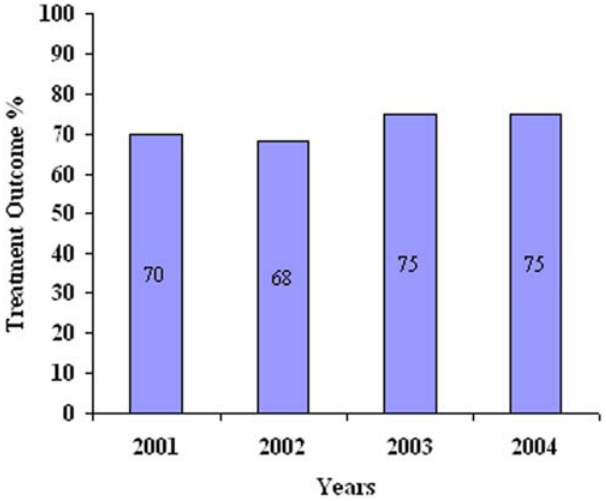
Figure 1. Trends in successful treatment outcomes for HIV-infected TB patients – An Giang, Vietnam,